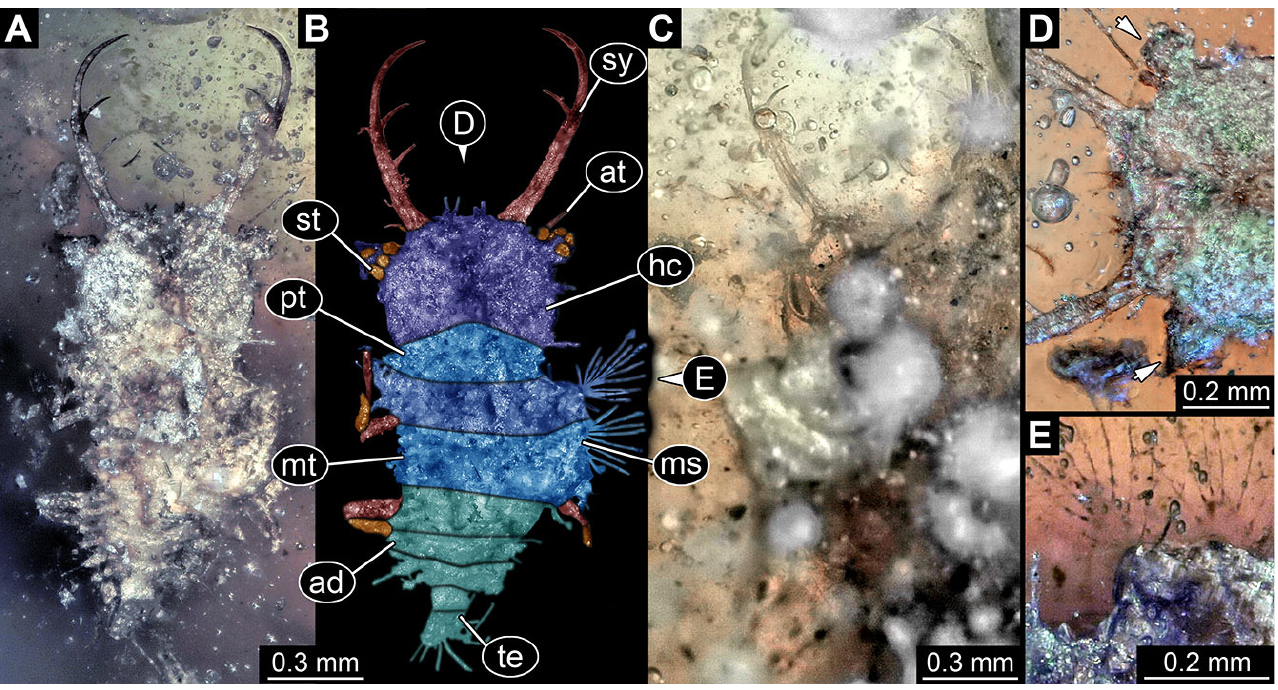
Figure 21. Fossil owllion larva, specimen 3234 (PED 0272), Cretaceous Kachin amber, Myanmar. ( A ) Overview, dorsal. ( B ) Color-marked version of ( A ). ( C ) Overview, ventral. ( D ) Close-up head capsule with fields of stemmata (arrows). ( E ) Close-up on dorsal processes. Abbreviations: ad = abdomen; at = antenna; hc = head capsule; ms = mesothorax; mt = metathorax; pt = prothorax; st = stemmata; sy = stylet; te = trunk end.